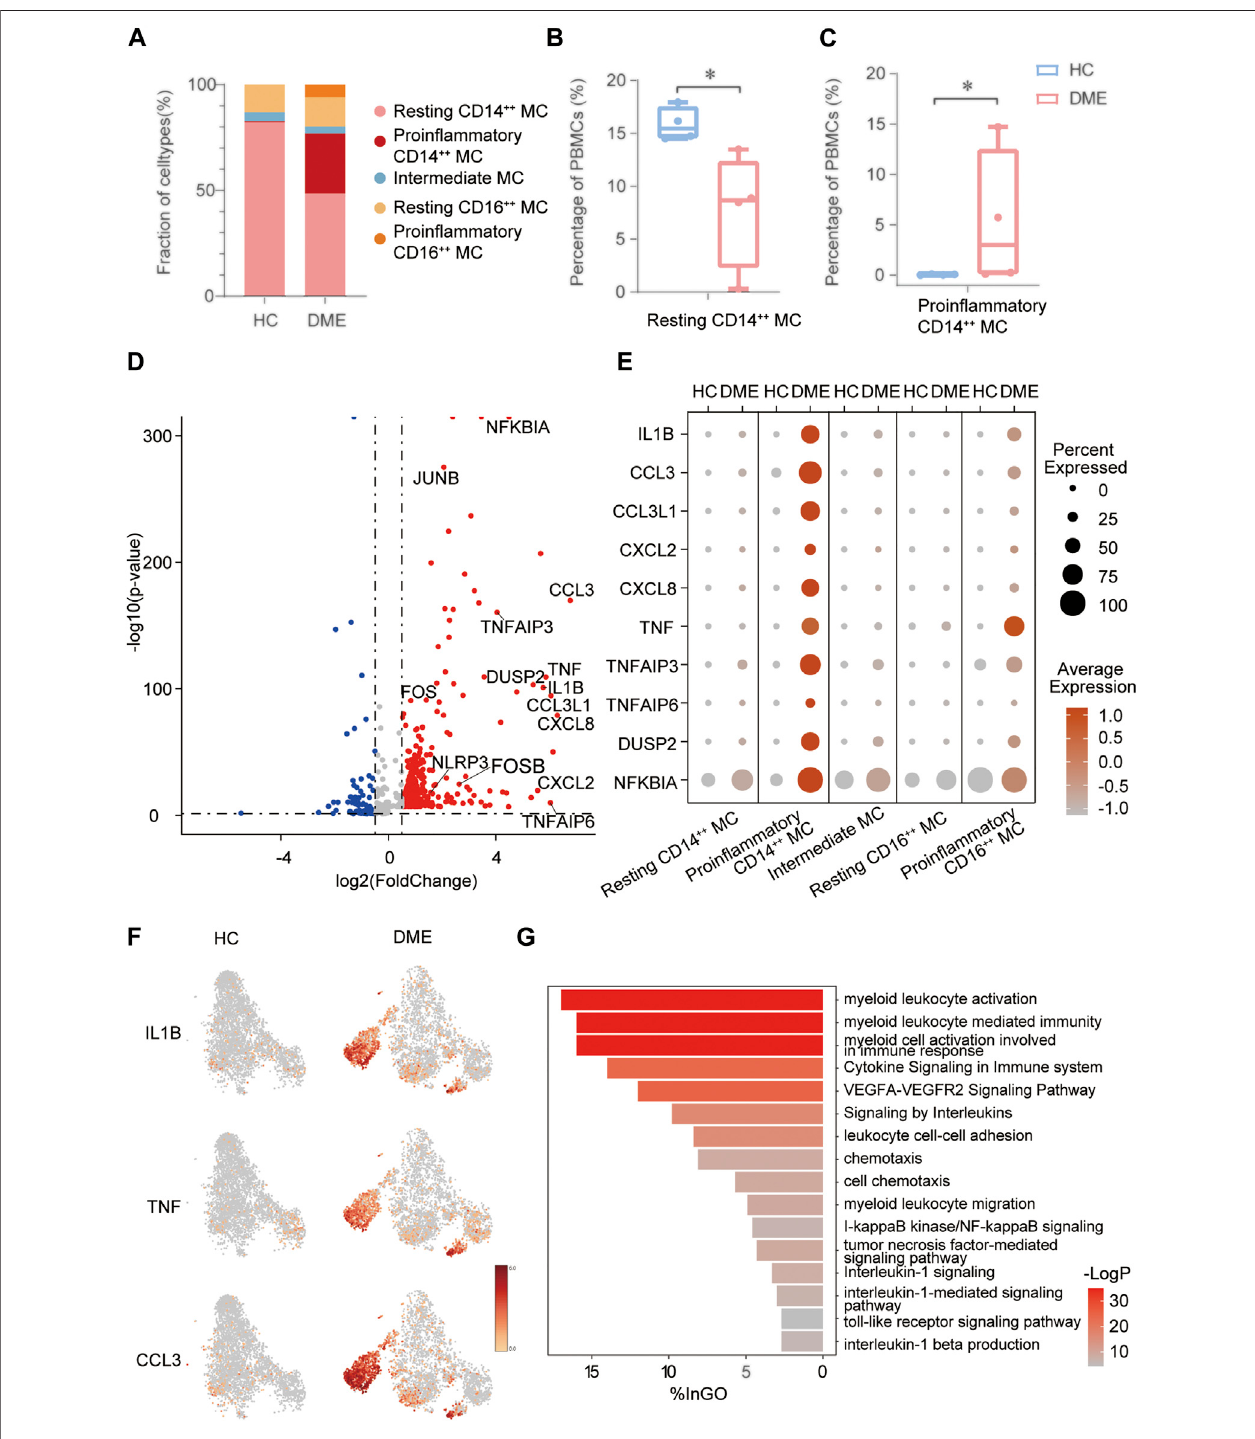
FIGURE4| Thein fl ammatorygenesandsignalingpathwaysenrichedinproin fl ammatoryCD14 ++ MC. (A) ComparationofrelativefractionsofMCsubsetsfromthe HC and DME group. (B) Quanti fi cation of resting CD14 ++ MC in PBMCs from the DME group compared to the HC group. (n (cid:1) 4, *: p value < 0.05). (C) Quanti fi cation of proin fl ammatory CD14 ++ MC in PBMCs from the DME group compared to the HC group. (n (cid:1) 4, *: p value < 0.05). (D) Volcano plot showing up-regulated and down- regulatedDEGsofMCinDMEcomparedtoinHC(DME:red;HC:blue). (E) Thedotplotshowingtheexpressionofin fl ammatorygenesinthe fi ve MCsubsetsfrom the HC and DME group. (F) The feature plot showing the expression of in fl ammatory markers from the HC and DME group. (G) The bar plot showing the signaling pathways enriched in proin fl ammatory CD14 ++ MC by Gene Ontology (GO) analysis.